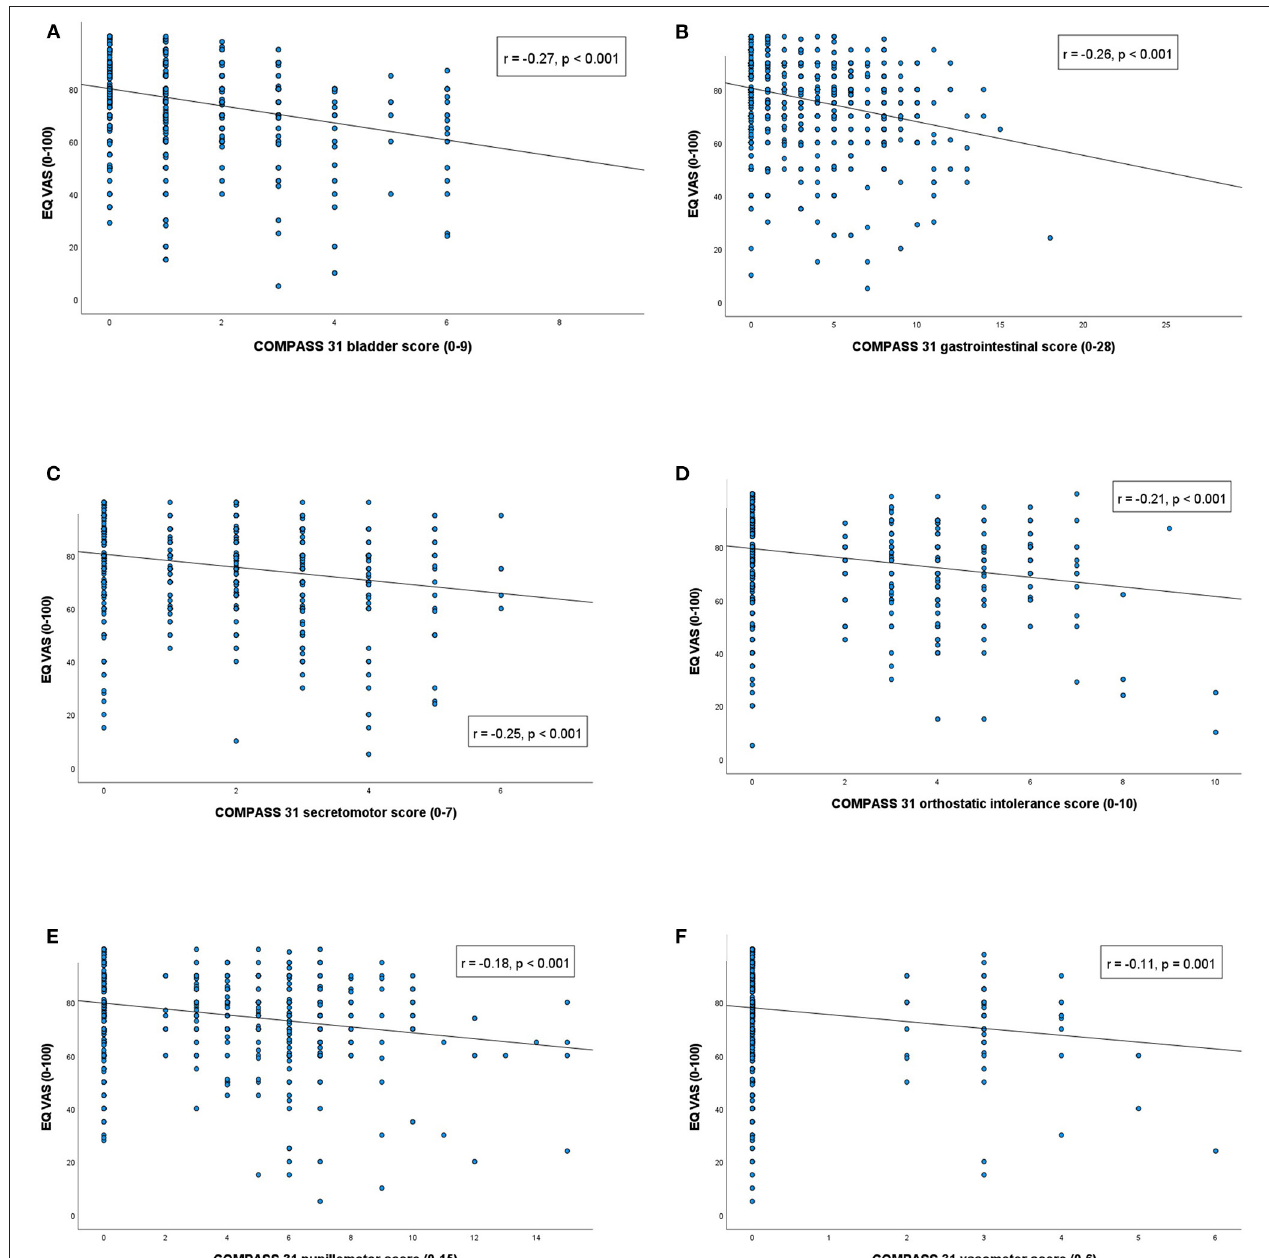
FIGURE 2 | Correlation between COMPASS 31 subscores and the Visual Analog Scale scores of the EuroQol five-level version of EQ-5D. Correlation values presented with Spearman’s rho correlation coefficient and p -value for each